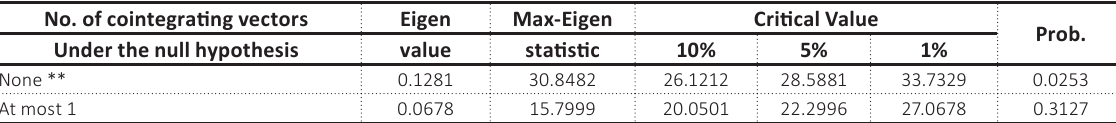
Table 3. Maximum Eigen